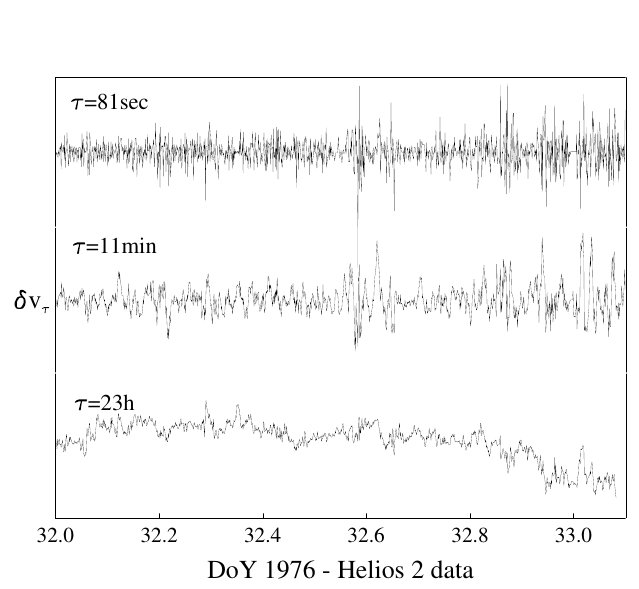
Figure 85: Differences for the longitudinal velocity 𝛿𝑢 𝜏 = 𝑢 ( 𝑡 + 𝜏 ) − 𝑢 ( 𝑡 ) at three different scales 𝜏 , as shown in the figure.